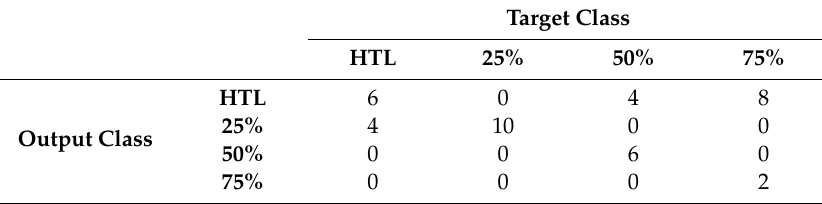
Table 6. Confusion matrix for the validation of the ANN classifier with extraction of statistical